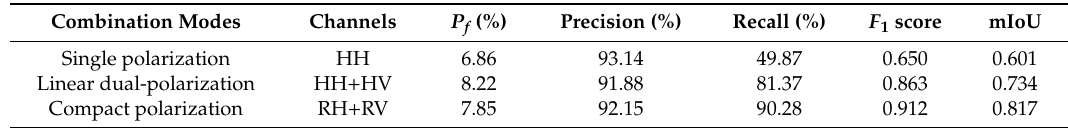
Figure 10. Illustration of results from different polarization modes. The white and red rectangles represent the detected targets and false alarms respectively, and the white circles represent the missed targets. Table 4. Comparison between different combination modes of polarization channels in the proposed method.